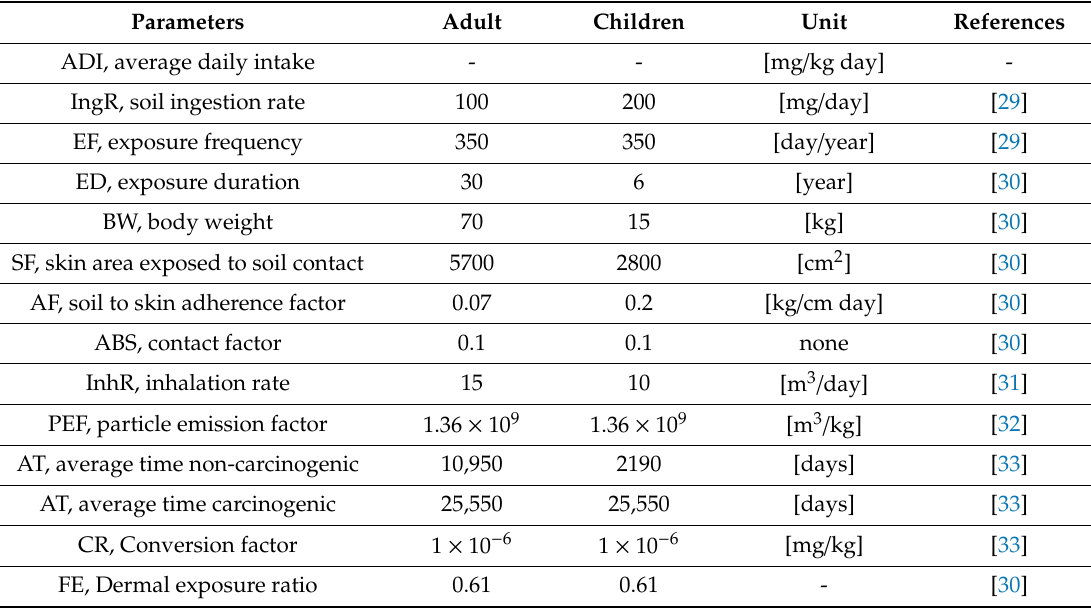
Table 4. Parameters of risk